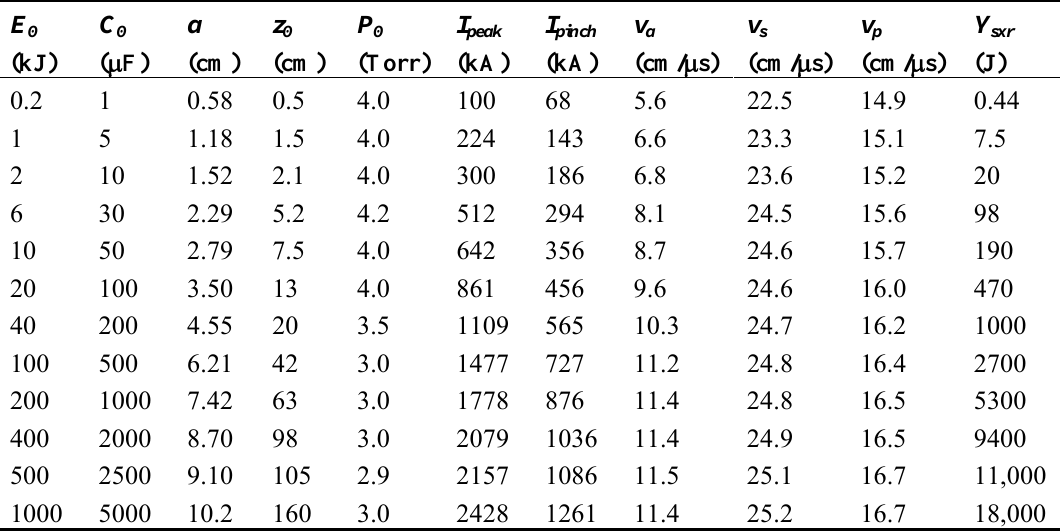
Table 2. Optimized configuration found for each E RESF = 0.1, c = 1.5, L fixed at 0.06, 0.7, 0.16 and 0.7, respectively. The v shock and radial piston speeds,